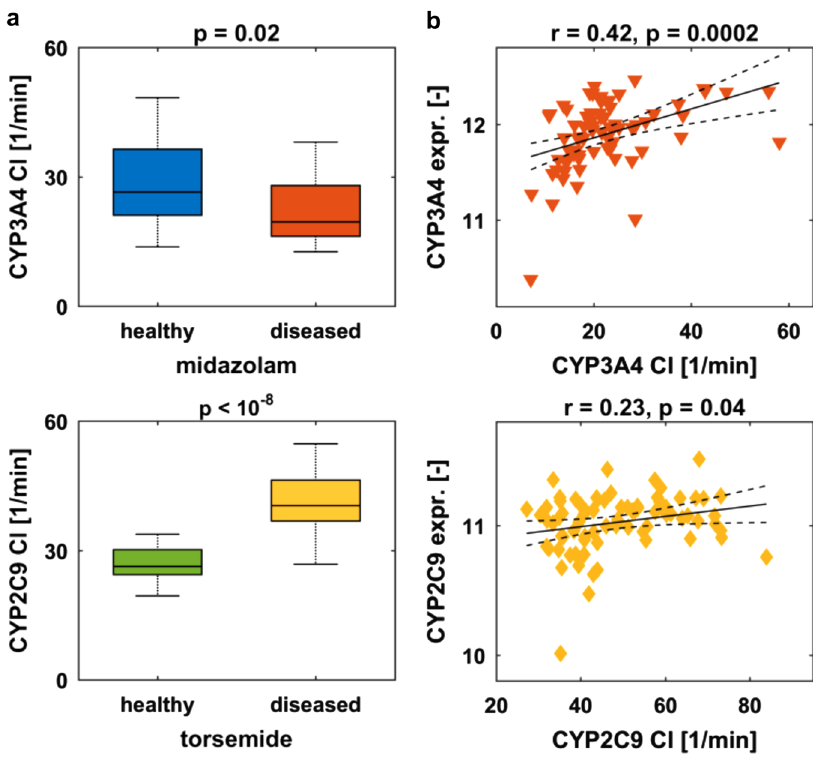
Fig. 6 Relationships between levels of measured enzyme expression and model-assessed enzyme-mediated clearance. a Comparison of the speci fi c CYP3A4-mediated clearance (CYP3A4 Cl) for midazolam, and that of CYP2C9 (CYP2C9 Cl) for torsemide, respectively, in the cohorts of 20 healthy individuals and 20 obese patients. Boxplots are de fi ned corresponding to Fig. 2. b Correlation of speci fi c hepatic clearance with expression levels of the indicated enzyme in all 79 diseased patients. Data are shown together with regression line and con fi dence interval for regression line ( dashed line